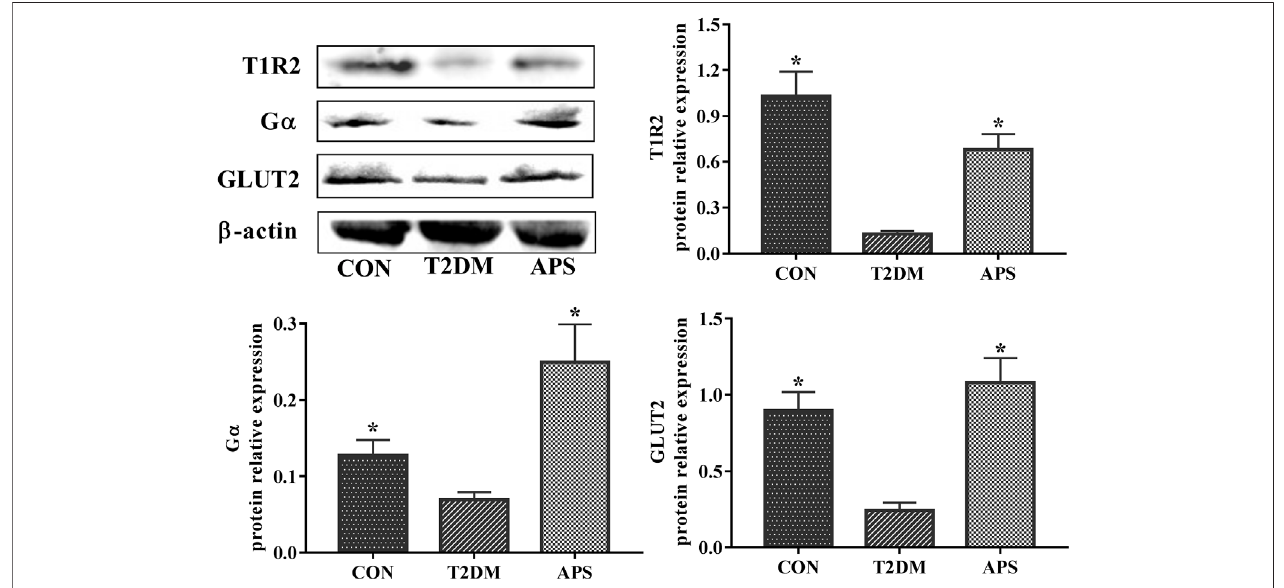
FIGURE4| Proteinexpressions ofT1R2, G α and GLUT2 inliverofexperimental rats. * p < 0.05, compared withratsinT2DM group; # p < 0.05, compared withrats in CON group.